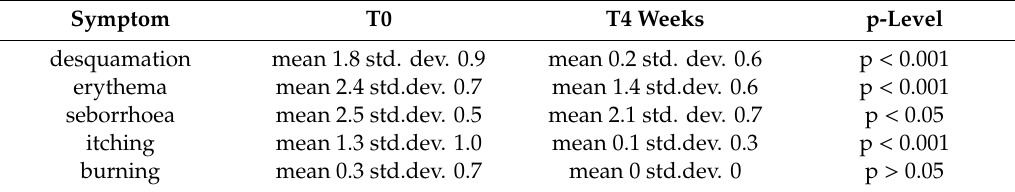
Table 9. Means, standard deviations and statistical significance (Wilcoxon test).